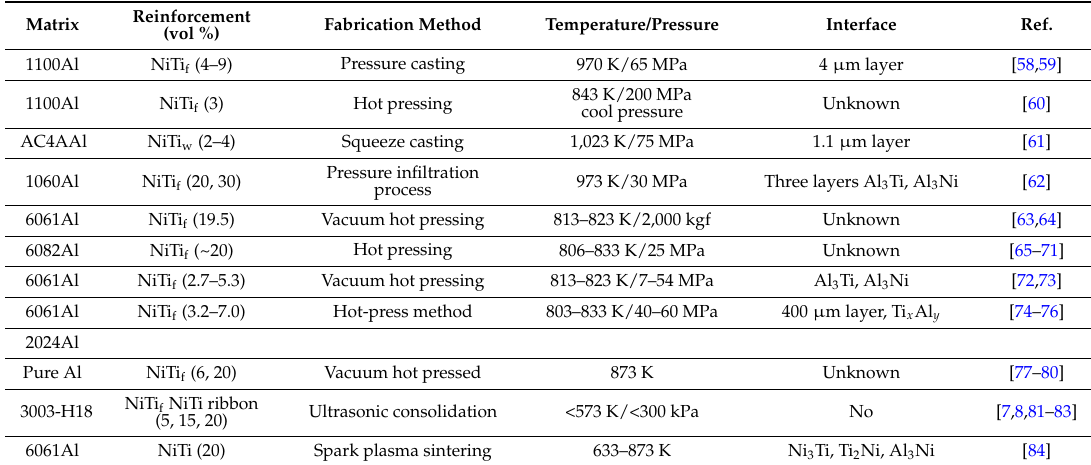
Summary of the AMCs reinforced with long SMA fiber/wire and their fabrication methods [12]. AMCs: aluminum matrix composites. SMAs: shape memory